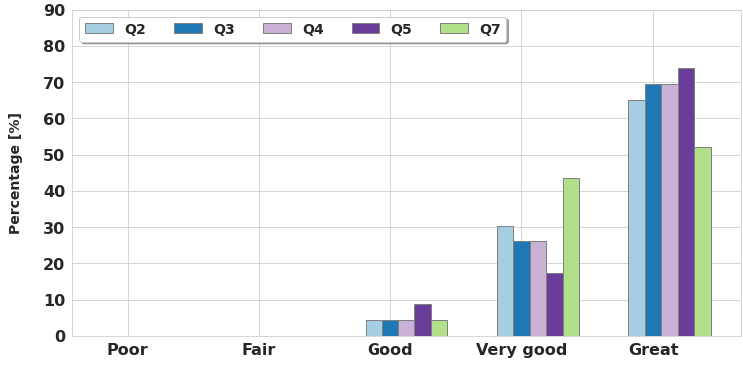
Figure 7. Survey responses to questions Q2, Q3, Q4, Q5, and